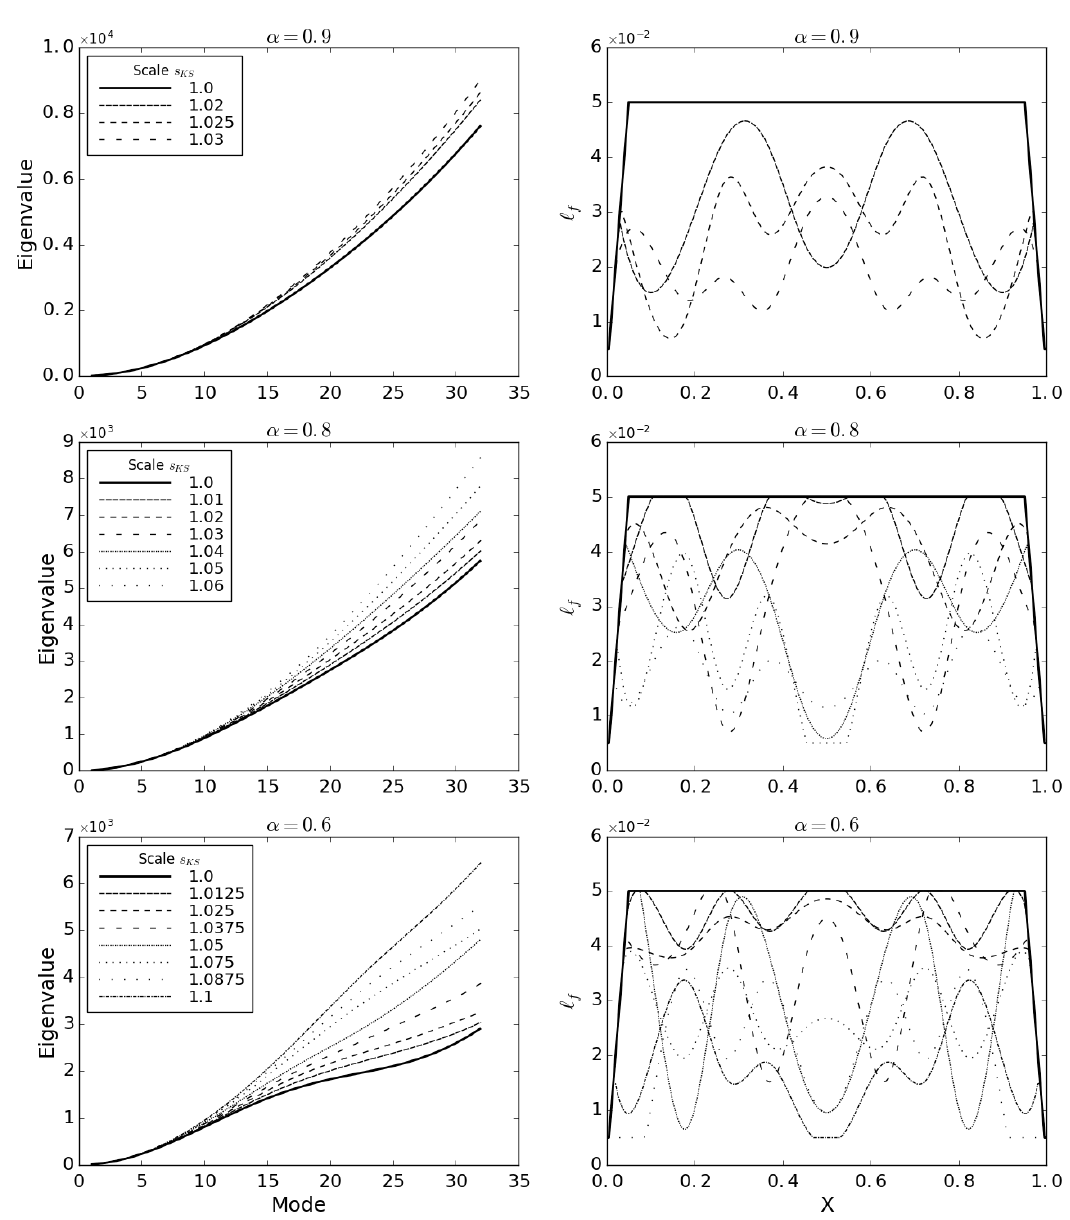
Figure 4. Eigenvalues ( left column ) and corresponding length scale distributions ( right column ) for particular material orders α ∈ { 0.6,0.8,0.9 } and (cid:96) f =